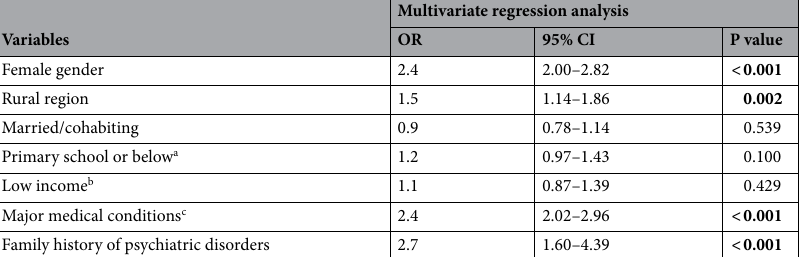
Table 4. Independent correlates of poor sleep quality by multiple logistic regression analysis. Bolded values: < 0.05; CI confidential interval, OR odds ratio. a Primary school or below = less than 7 years of